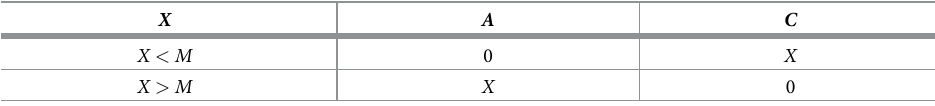
Table 9. All-nothing deductible with participation M